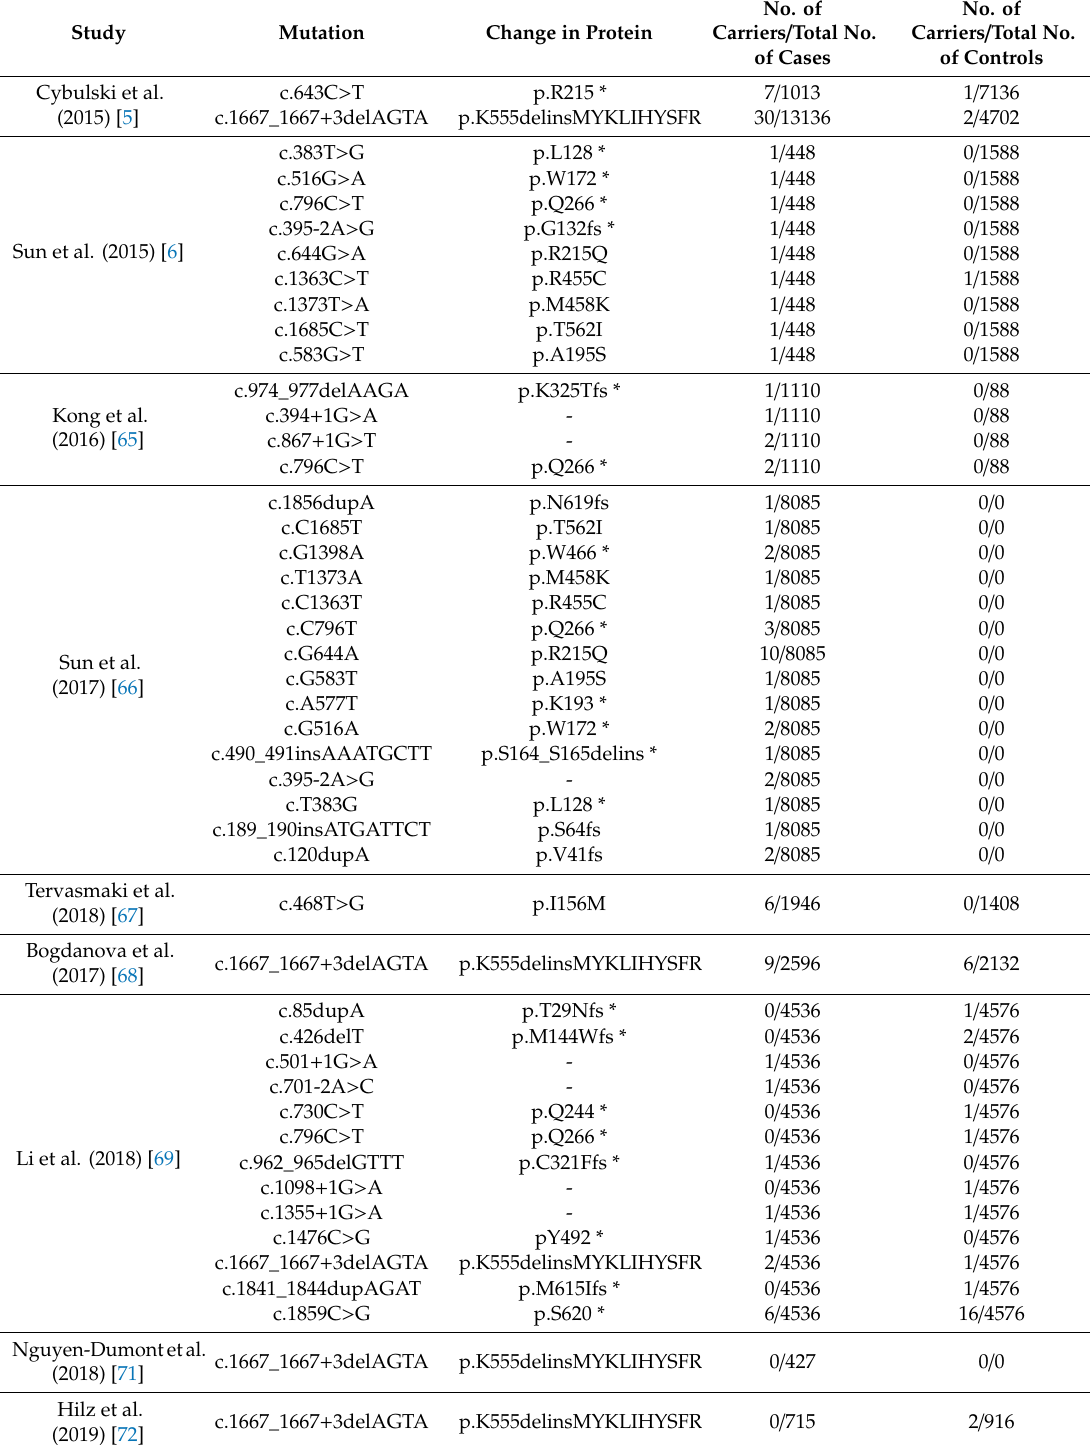
Table 2. Reported breast cancer risk-associated RECQ1